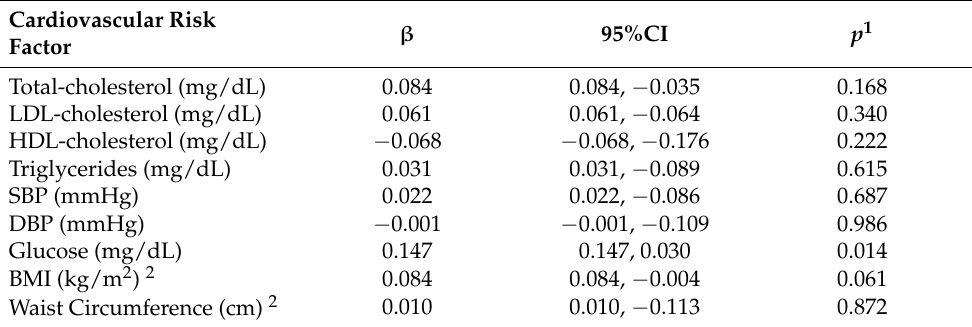
Table 7. Overall combined effect of trace elements (Zn, Cu, Se, and Mn) in urine and cardiovascular risk factors. Based on quantile-g-computation approach.